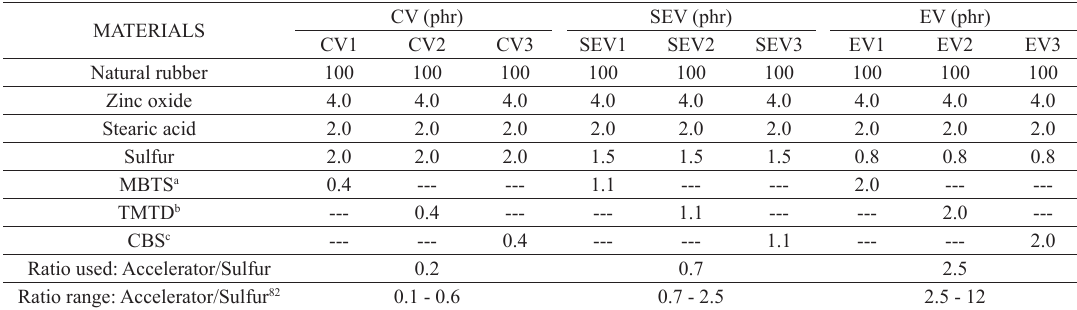
Table 1. Formulations and vulcanization properties for rubber compounds produced with various accelerators.